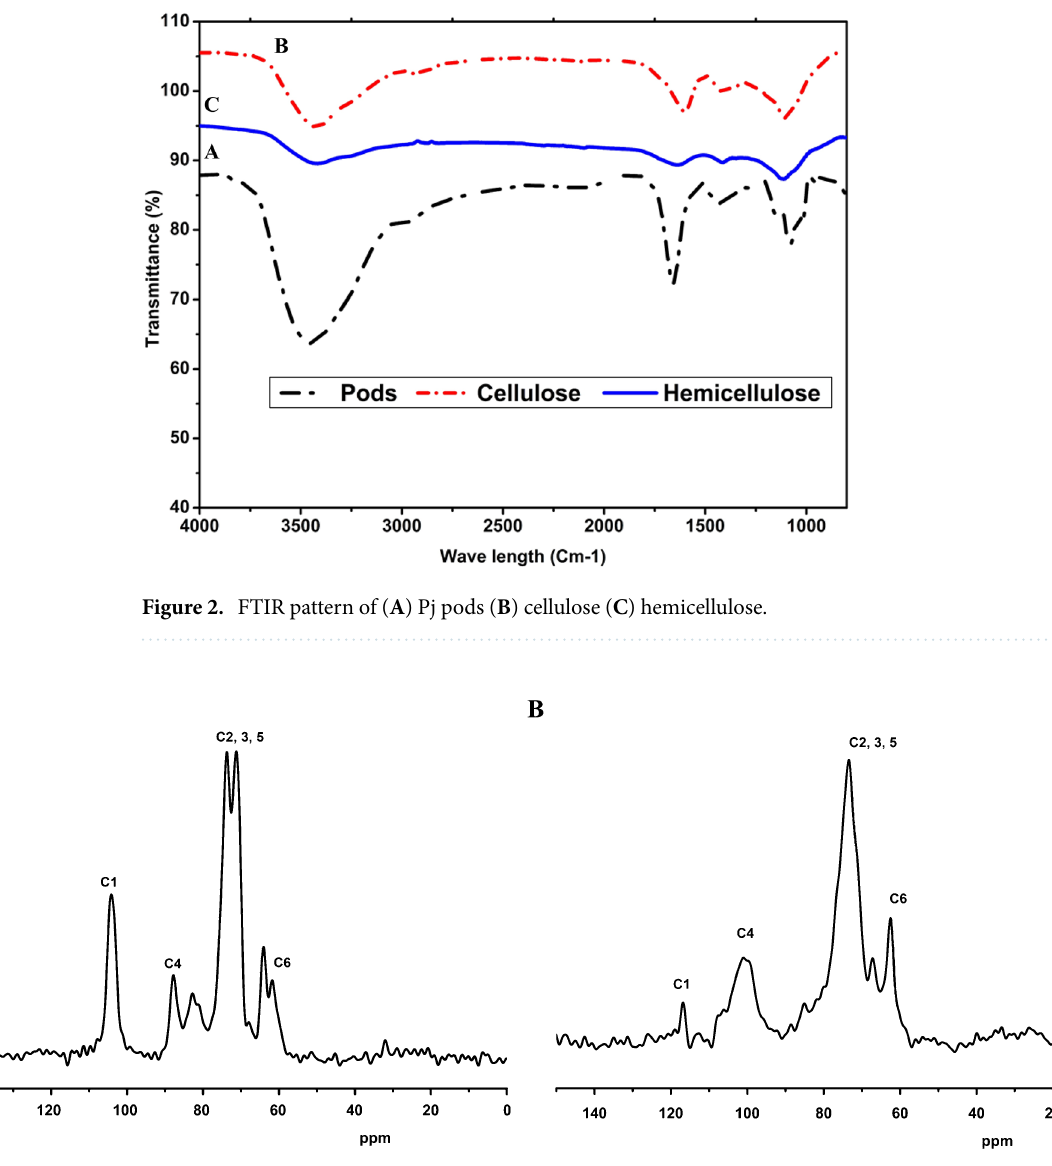
Figure 3. CP/MAS NMR ( A ) cellulose ( B )